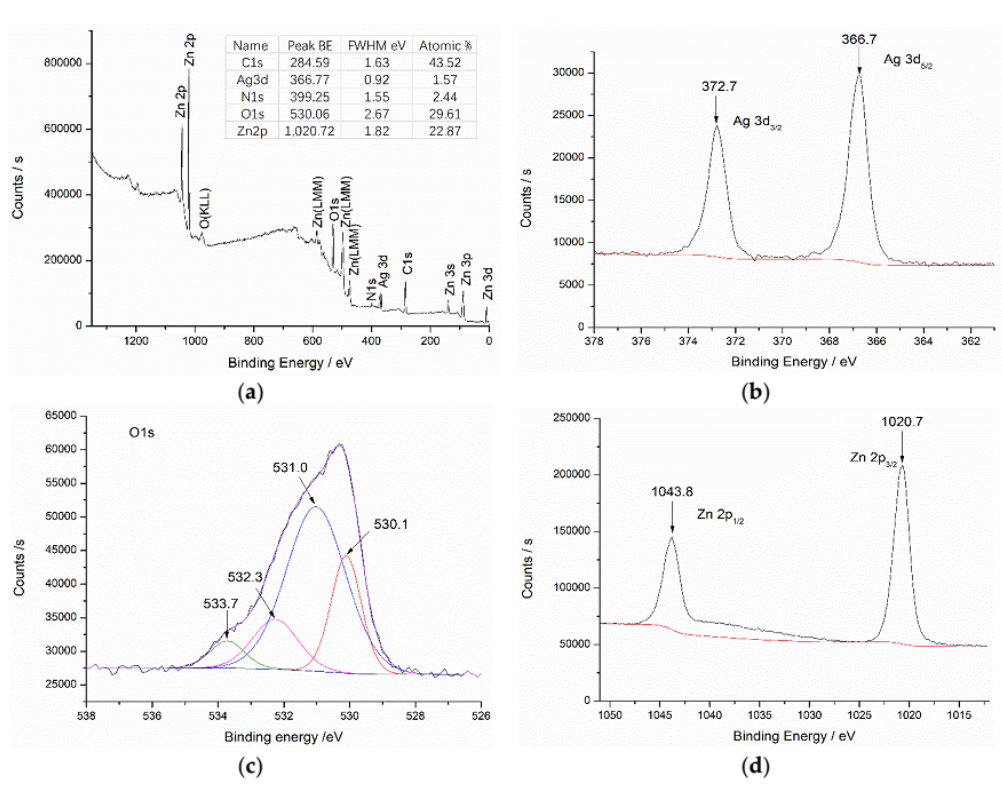
Figure 7. X-ray photoelectron spectroscopy of ZnO/Ag composite coated polyester nonwoven (4#)